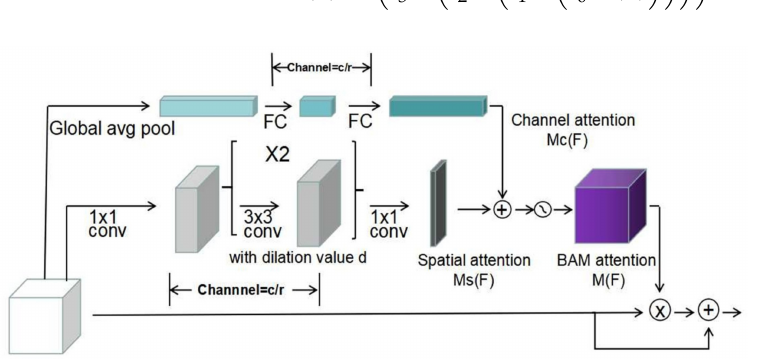
Figure 2. The attention module structure of this paper consists of two modules: channel attention and spatial attention. The two modules run in parallel, and the weighed matrixes of each channel of the sample features and of each image pixel in the channel are obtained spontaneously and then integrated into the original sample